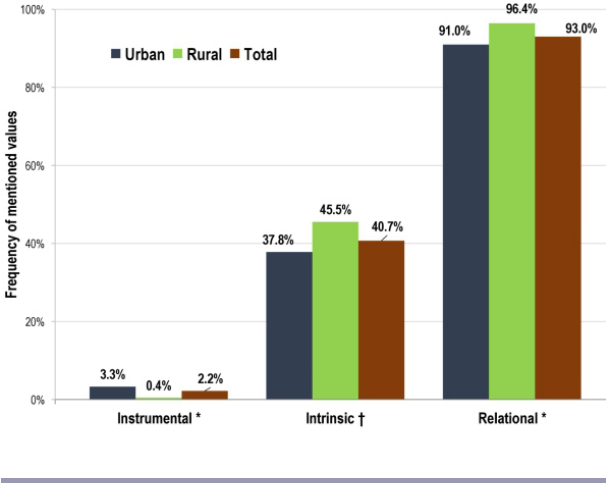
Fig. 3. Frequency (%) of the mention of value domains by urban and rural respondents. Asterisks indicate statistically significant differences between urban and rural